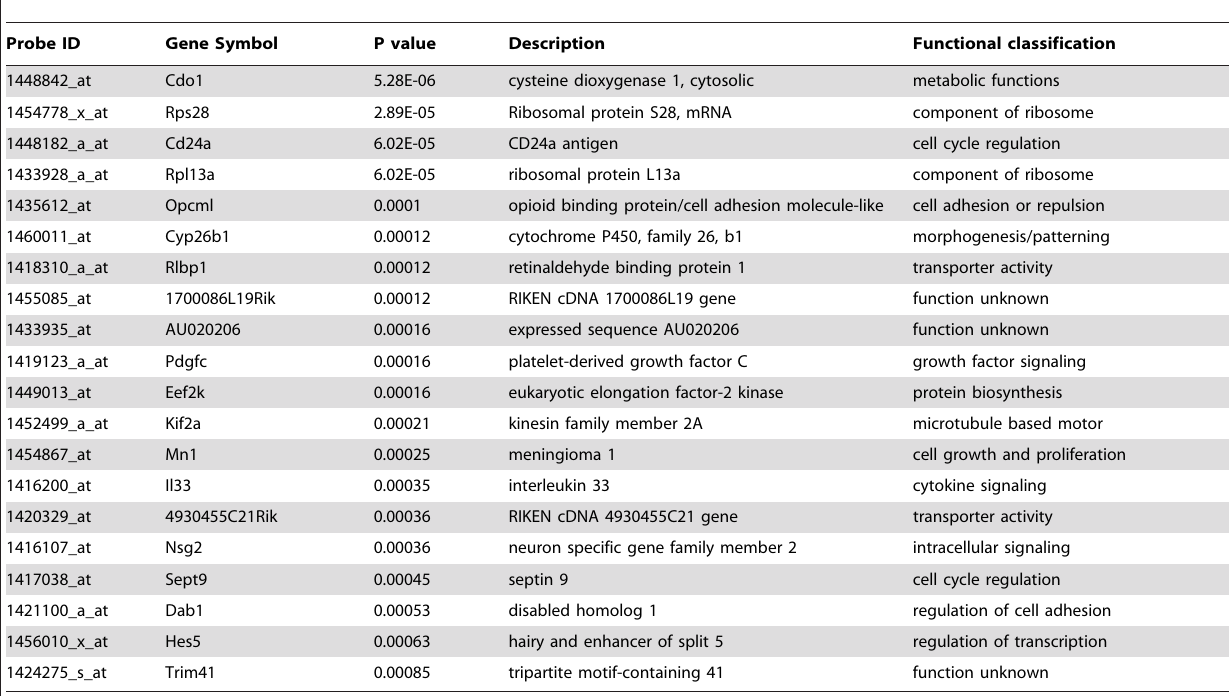
Table 2. Top 20 probe-sets present at P6 and absent at P30 (ranked by P values).